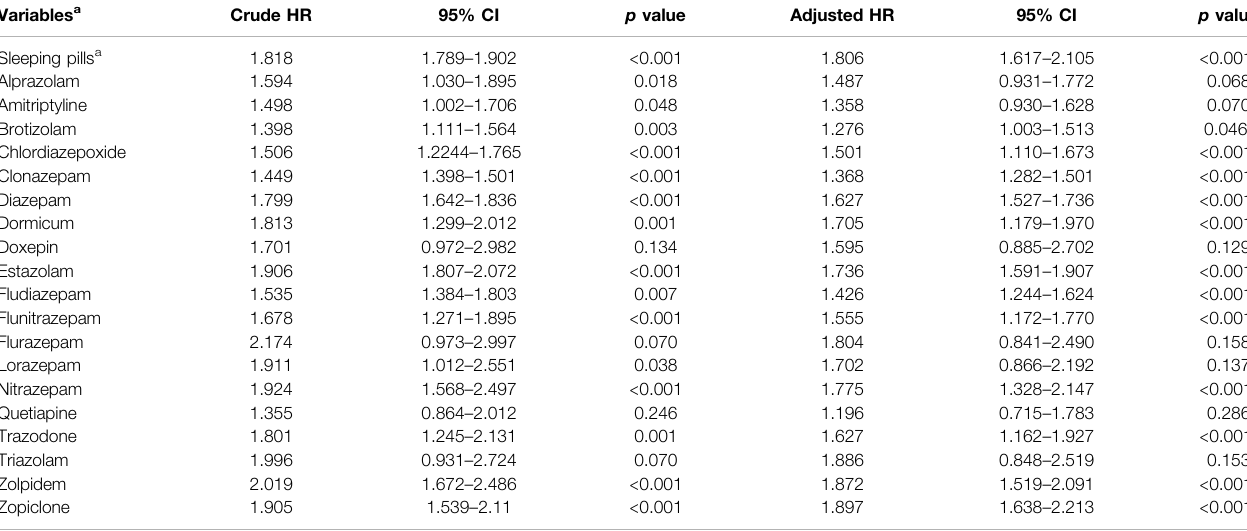
TABLE 4 | Crude and adjusted odds ratios of CKD associated with various sleeping pills administration during the follow-up period in the study cohort. Variables